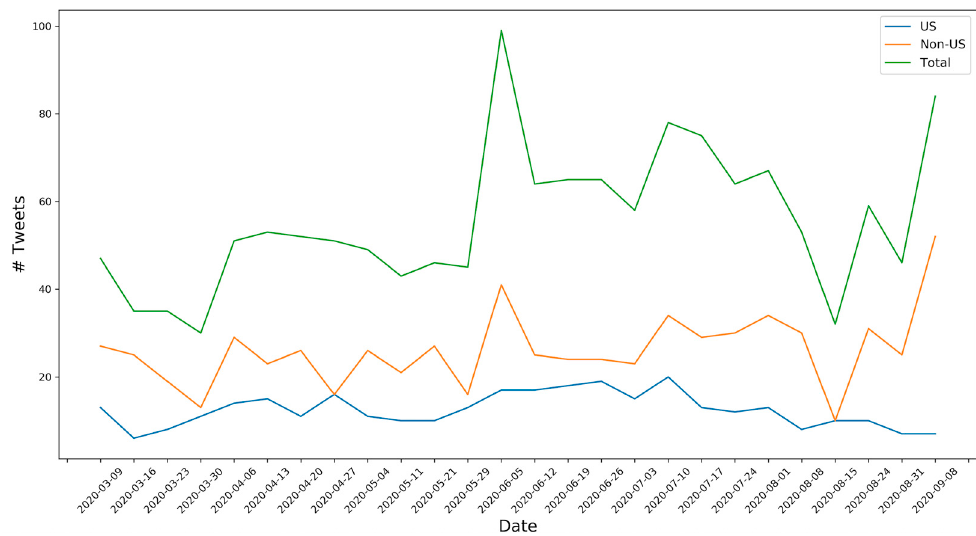
Figure 1. Temporal trend of the number of tweets related to disposable electronic cigarettes (e-cigarettes).